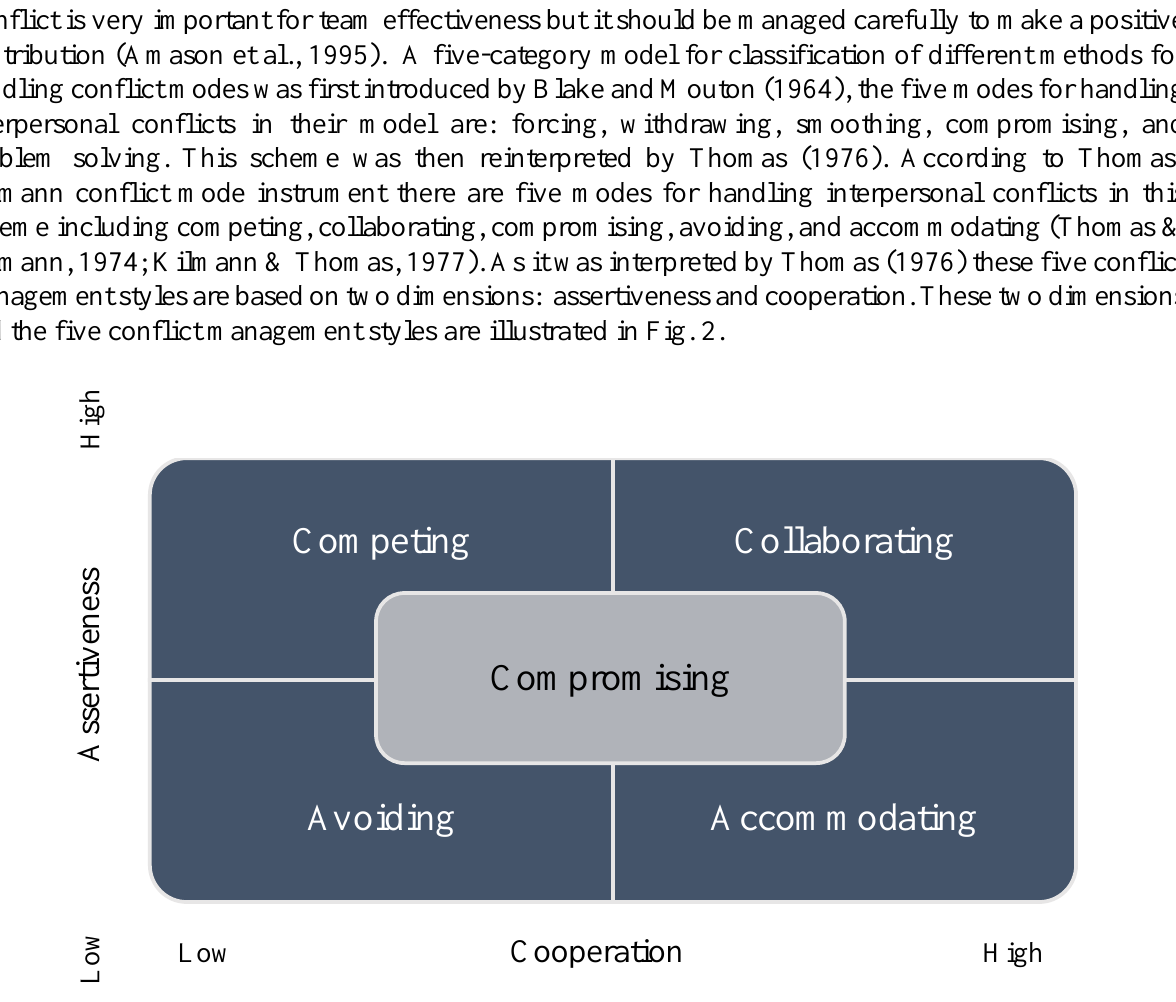
Fig. 2. Based on Thomas-Kilmann conflict mode